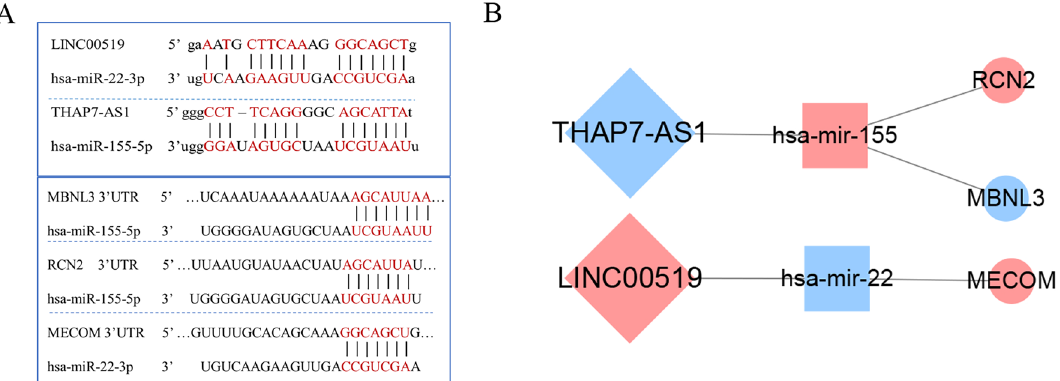
Figure 6. ( A ) Prediction of binding sites of lncRNA-miRNA and miRNA-mRNA in three key networks. ( B ) The construction of three ceRNA networks: LINC00519/ hsa-mir-22/MECOM, THAP7-AS1/hsa-mir-155/ MBNL3, and THAP7-AS1/hsa-mir-155/RCN2; the shape represents the type of RNA, blue means down- regulation in cancer samples and red means up-regulation in cancer